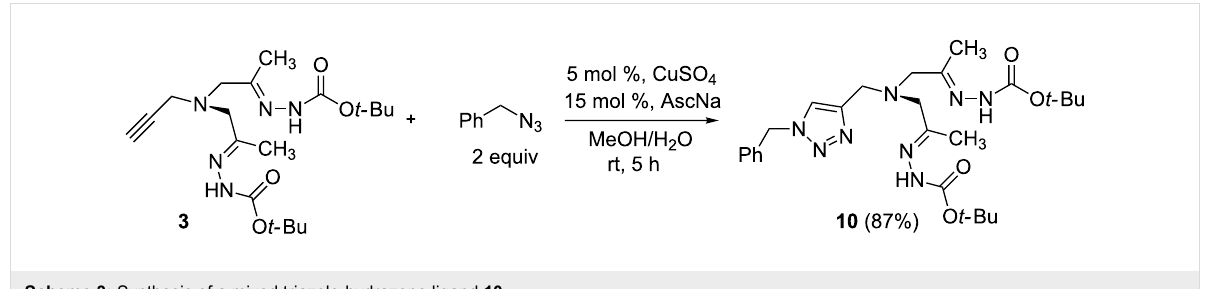
Scheme 3: Synthesis of a mixed triazole-hydrazone ligand 10 .